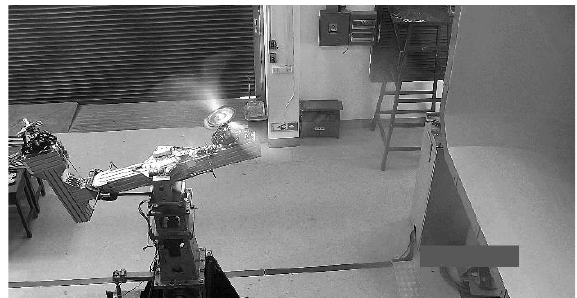
Figure 4. Isolated rotor test of autorotation in forward flight.